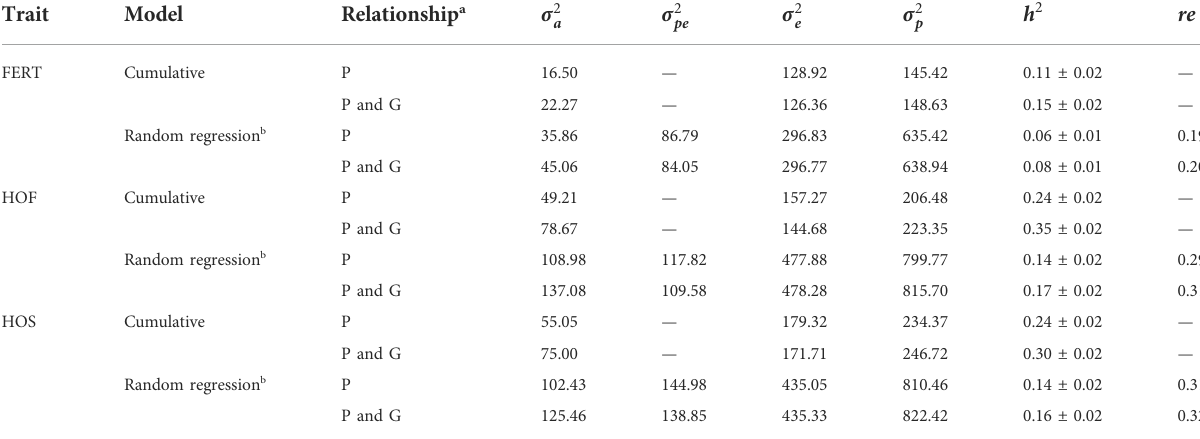
TABLE 4 Estimates of additive, permanent, error, and phenotypic variances, heritability, and